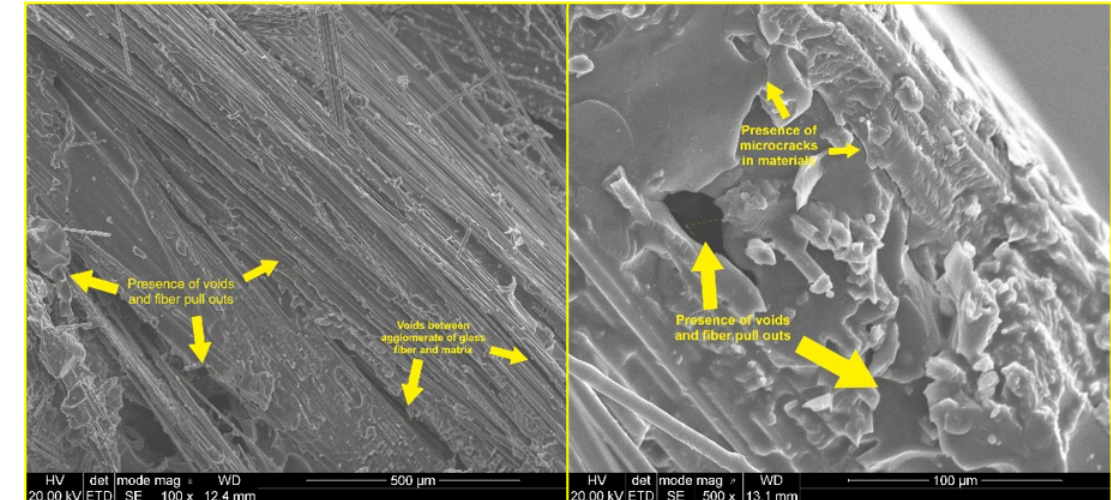
Figure 8. SEM images of the sample coded 50% GF.